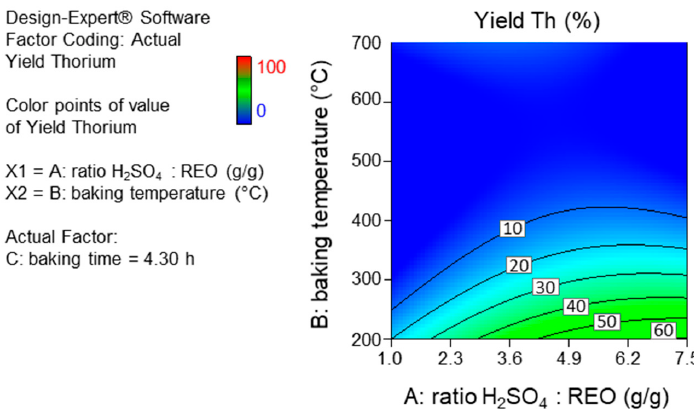
Figure 14. Contour diagram for the response “Yield P” for the combined effects of ratio of H 2 SO 4 to REO and baking temperature. The baking time was set to 4.3 h.